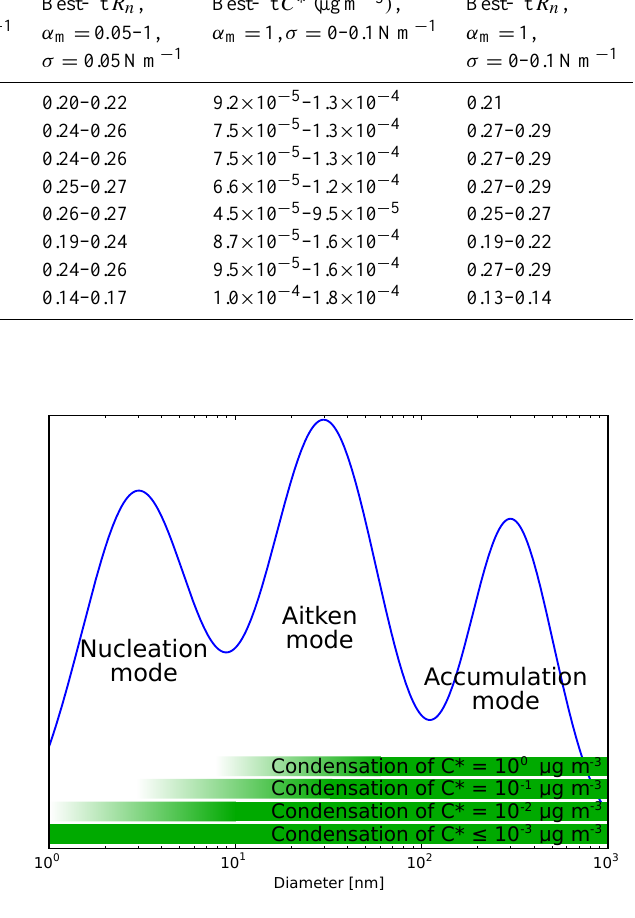
Fig. 9. Schematic demonstrating roughly where organic aerosol will net condense onto particles. The exact details of the lower-bound diameter of condensation depend greatly on the surface tension of the aerosol and the time-dependent activity (aerosol-phase mass or mole fractions in most SOA frameworks) of the condensing species; thus, the specific values in this figure should not be used as a refer- ence. Lower volatility species will more readily condense onto (or partition into) freshly nucleated particles. The results of this study showed that SOA needs a saturation vapor concentration of less than 10 − 3 to 10 − 2 µgm − 3 in order to grow freshly nucleated